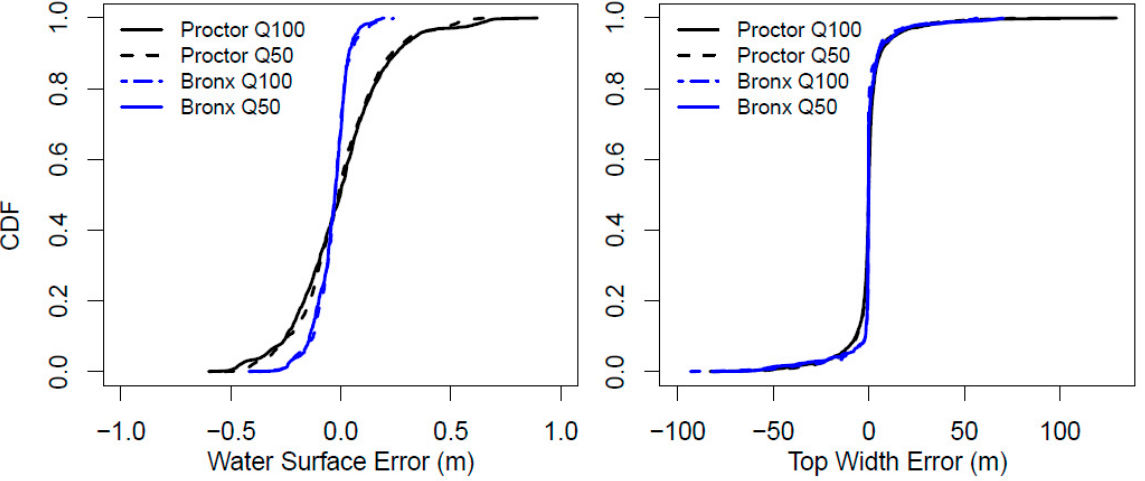
Figure 7. Cumulative distribution of the absolute depth ( left ) and inundated top width ( right ) errors in SUB relative to MCS.